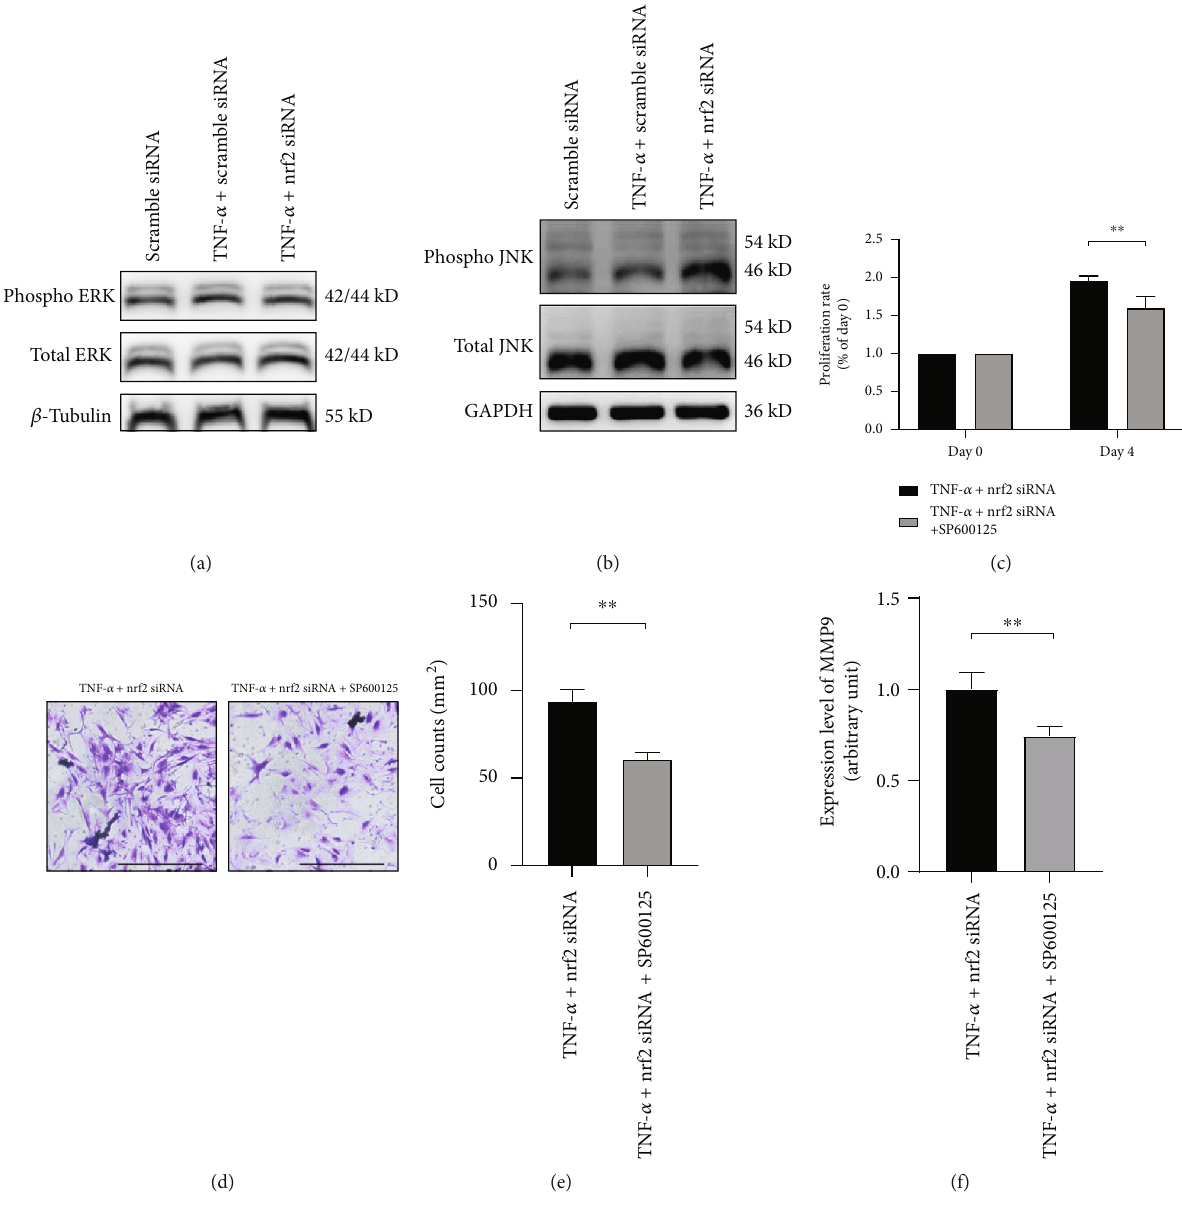
Figure 6: JNK pathway mediates the modulation of proliferation, invasion, and MMP9 expression in RA-FLS by nrf2. (a) After transfection with scramble siRNA or nrf2 siRNA for 3 days, RA-FLS were further stimulated with/without TNF- α (25 ng/mL) for 24h. Representative fi gures show the phosphorylation of ERK examined by Western blotting. β -Tubulin was used as the housekeeping gene. (b) Representative fi gures show the phosphorylation of JNK examined by Western blotting. GAPDH was used as the housekeeping gene. (c) After transfection with nrf2 siRNA for 3 days, the proliferation of RA-FLS was analyzed by CCK-8 assay. Cells were cultured in the 96-well plate and stimulated with TNF- α (25 ng/mL) in the presence or absence of SP600125 (20 μ M) for 4 days. (d, e) After transfection with nrf2 siRNA for 3 days, invasion of RA-FLS was analyzed with transwell assay. Cells were cultured in the transwell chamber and stimulated with TNF- α (25 ng/mL) in the presence or absence of SP600125 (20 μ M) for 2 days. (f) After transfection with nrf2 siRNA for 3 days, RA- FLS were further stimulated with TNF- α (25 ng/mL) in the presence or absence of SP600125 (20 μ M) for 24 h. The MMP9 mRNA expression was examined by real-time PCR. Scale bar represented 200 μ m. N = 3 . Data were shown as the mean ± SD ; ∗∗ p < 0 : 01